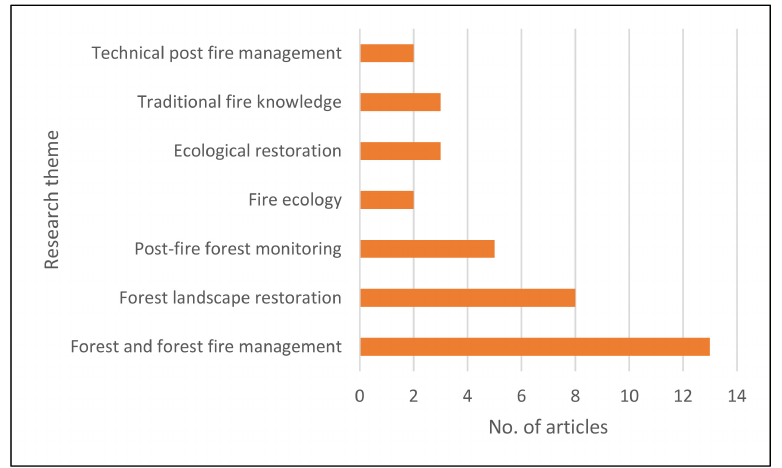
Figure 3. Number of articles based on research themes ( n =